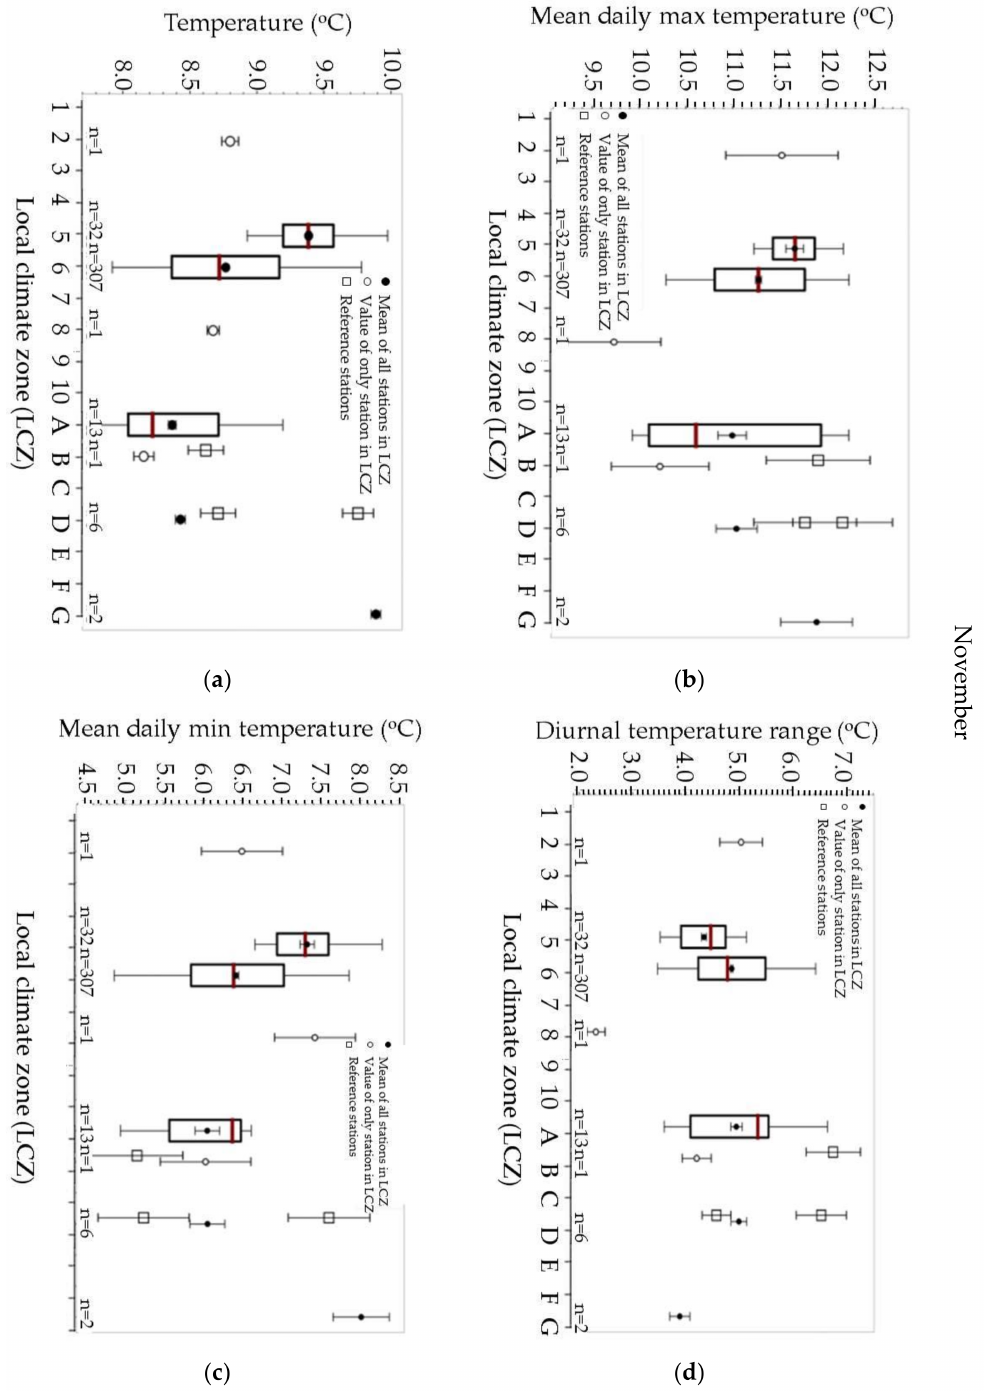
Figure A3. Local climate zone (LCZ) temperature characteristics in November 2018: ( a ) is the mean temperature over the entire month, ( b ) is the mean daily maximum temperature, ( c ) is the mean daily minimum temperature, and ( d ) is the mean diurnal temperature range. LCZs associated with urban landscapes (LCZs 1-10) are on the left side and those associated with rural landscapes (LCZs A–G) are on the right side. n represents the number of valid stations in that LCZ. Filled dots represent the mean of all Netatmo stations in each LCZ, unfilled dots represent the value of the only Netatmo station in an LCZ and squares represent values of reference stations. Box plots are also displayed for LCZs with more than ten stations present. The maroon central line represents the median, the upper and lower bands of the box are the 75th and 25th percentiles and the upper and lower whiskers are the 95th and 5th percentile. The method of error calculation of the means is shown in Appendix